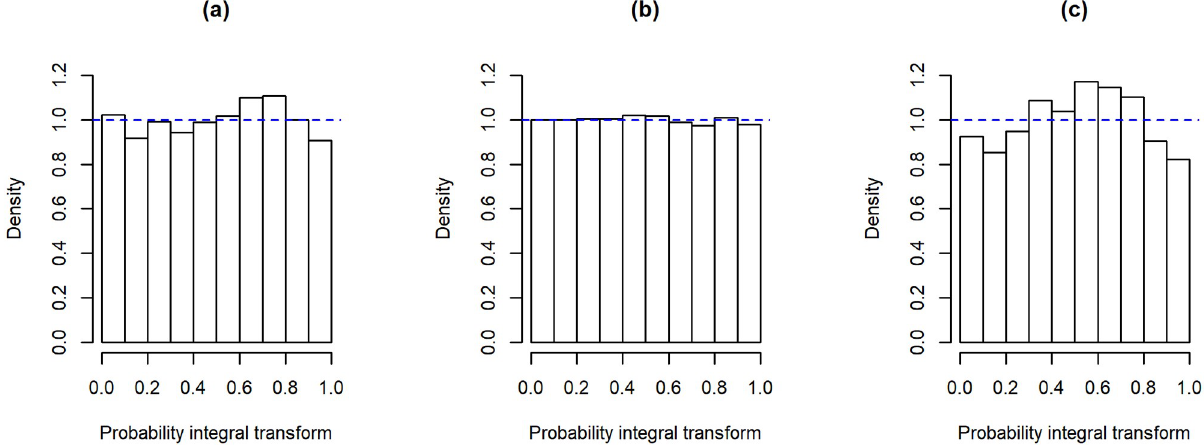
Fig 9. PIT histograms for the M F model in 3 locations. (a) Valongo, (b) location with PIT closest to uniformity and (c) location with PIT furthest to uniformity.